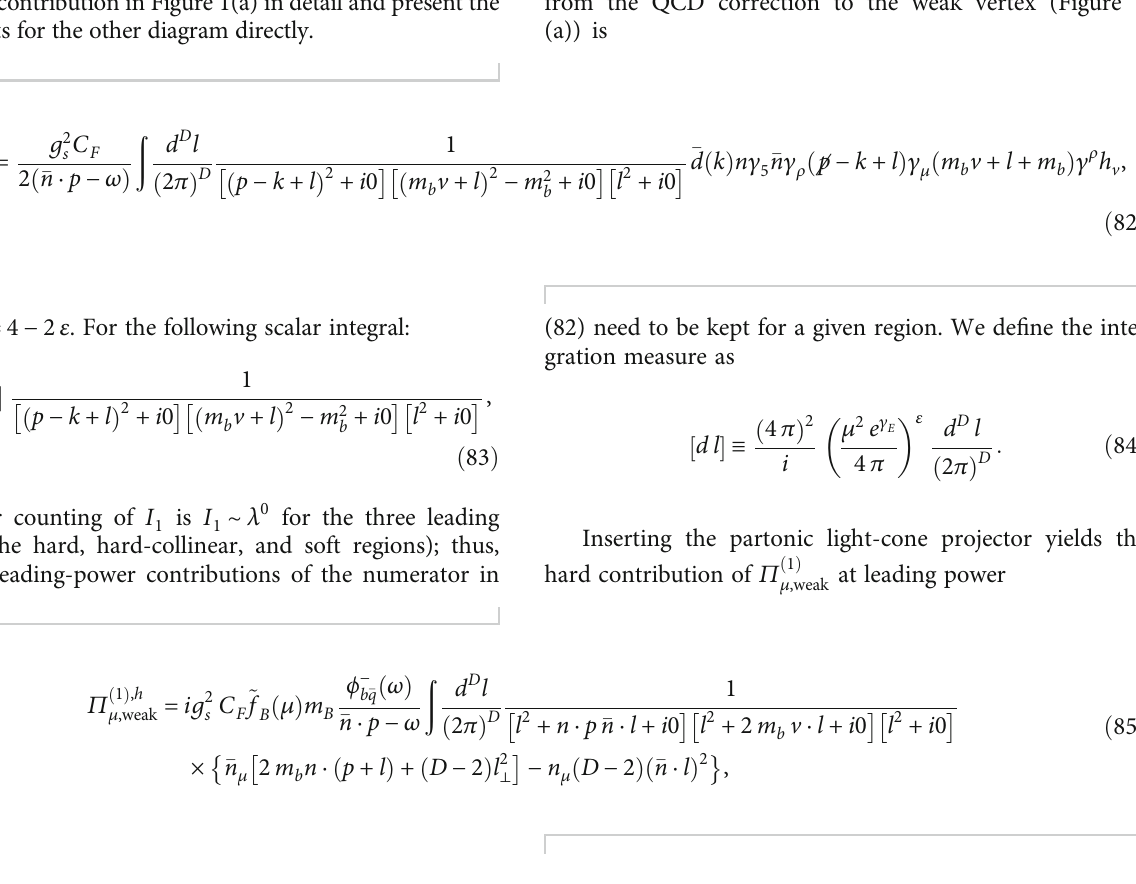
(cid:1) n · p Þ at O ð α Þ . Figure 1 is reproduced from [32]. μ ð n · p , s